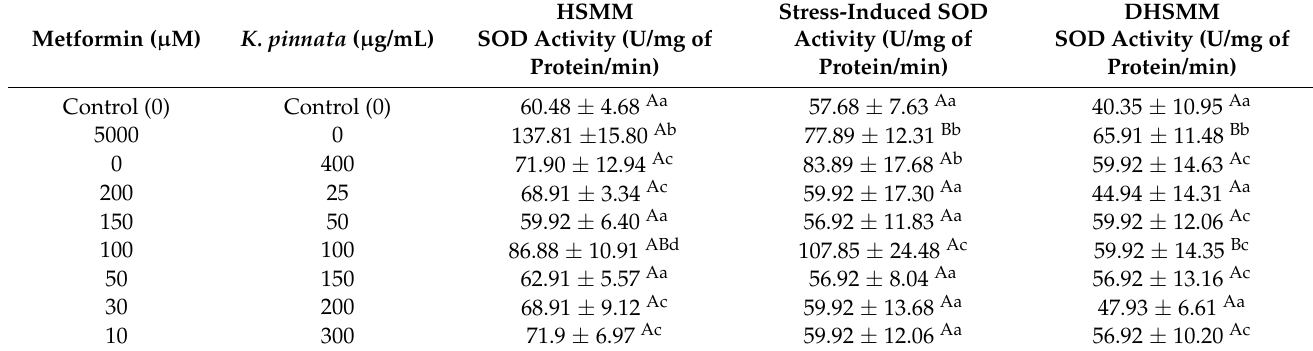
Table 4. Observed cellular superoxide dismutase (SOD) activity in cells after 72 h of treatment. Data are presented as mean ± standard error of the mean. Significant differences are indicated by different letters (uppercase letters within row; lowercase letter within column for each treatment option) according to Tukey post hoc test ( p < 0.05): control (no treatment); human skeletal muscle myoblast (HSMM); diabetic human skeletal muscle myoblast (DHSMM).